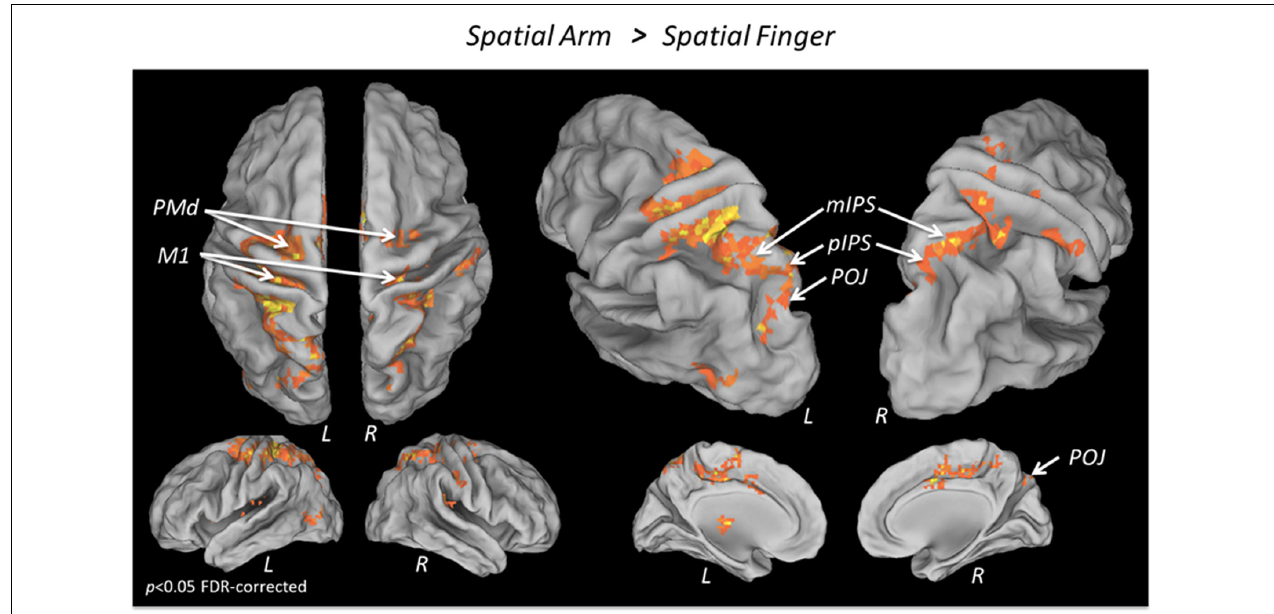
FIGURE 2 | fMRI BOLD response during Spatial reach planning. Areas showing a significantly greater BOLD response in the Spatial Arm as compared to the Spatial Finger condition, overlaid on an inflated cortical surface ( p < 0.05 FDR; no significant activation for the reverse contrast Spatial Finger > Spatial Arm). TABLE 2 | Average MNI coordinates (in mm) of clusters showing significantly more activity in the Spatial Arm as compared to the Spatial Finger condition. Anatomical region Functional label (Brodmann area) Hemisphere x y z t -value Spatial Arm > Spatial Finger